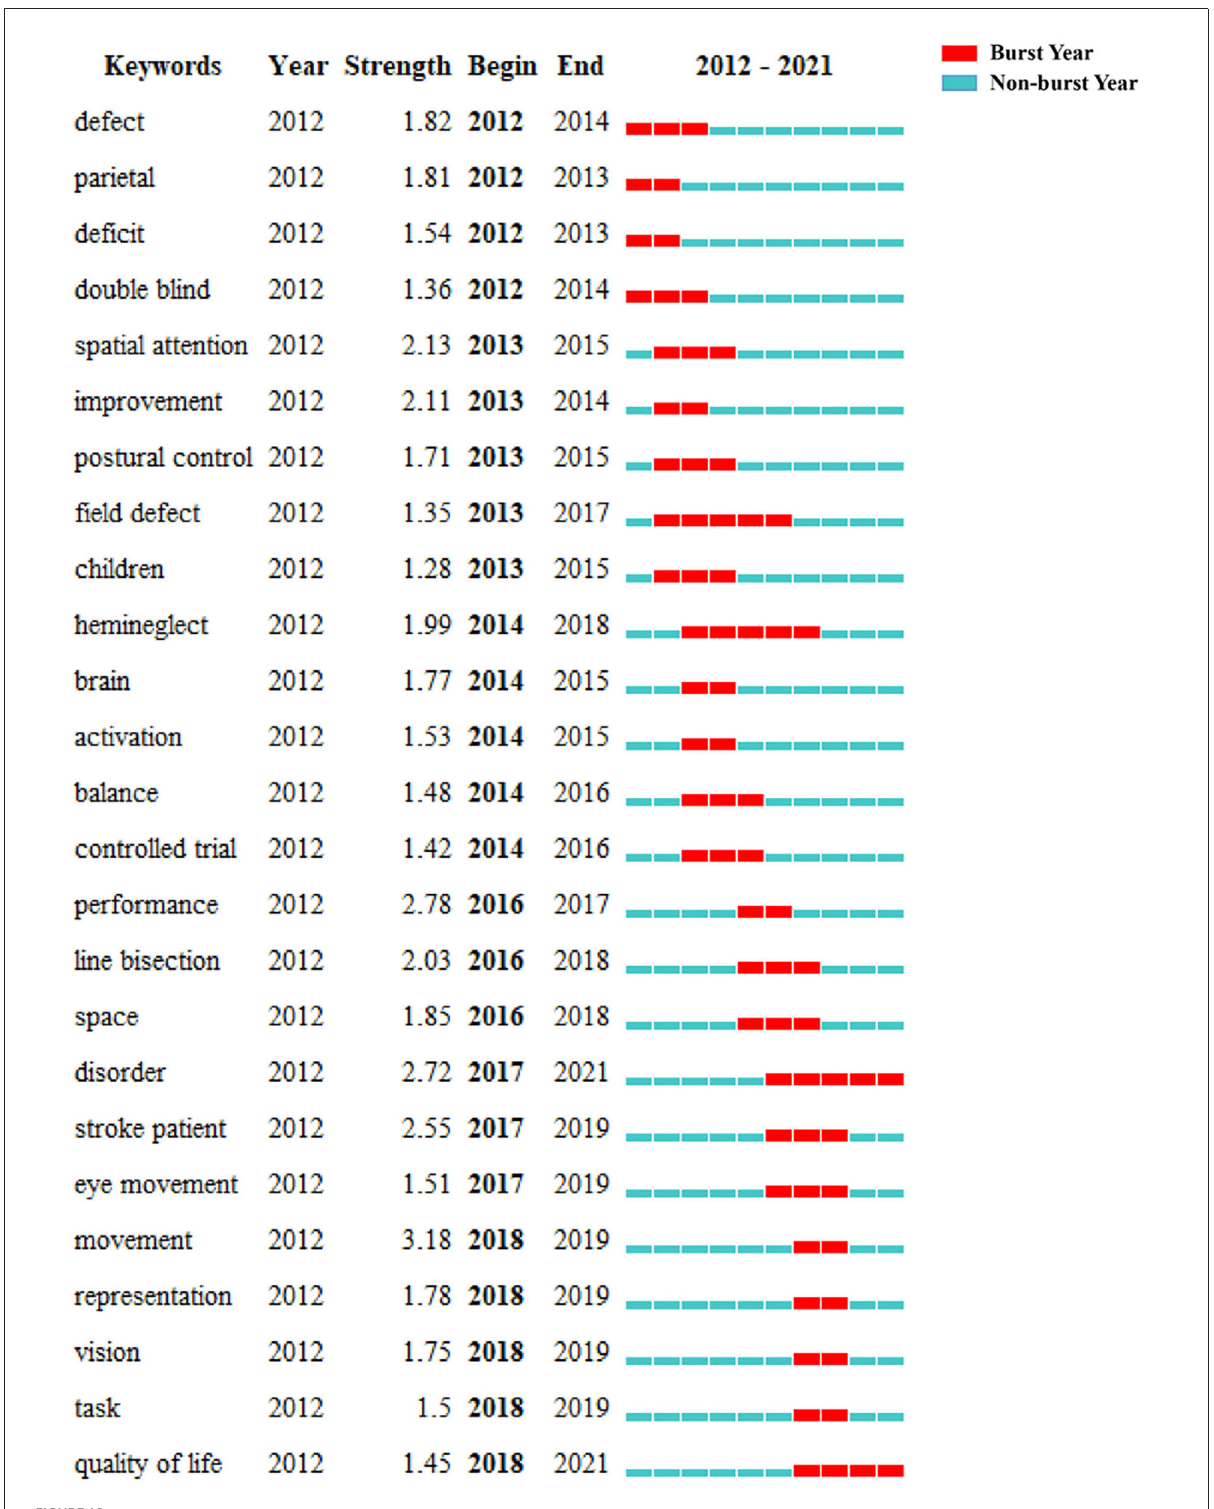
FIGURE10 The top 25 keywords with the strongest citation